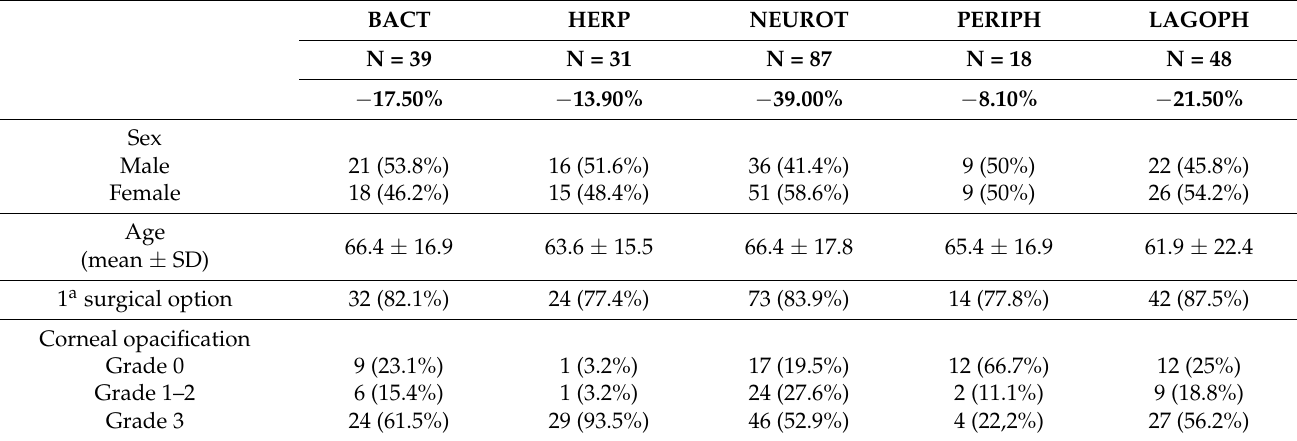
Figure 2. Flowchart of success and failure after amniotic membrane transplantation. Sex distribution analysis revealed that 46.6% (n = 104) of the 223 AMTs were performed in male patients and 53.4% (n = 119) in female patients (Table 1). The mean age of Table 1. Amniotic membrane transplantation for each type of ulcer .